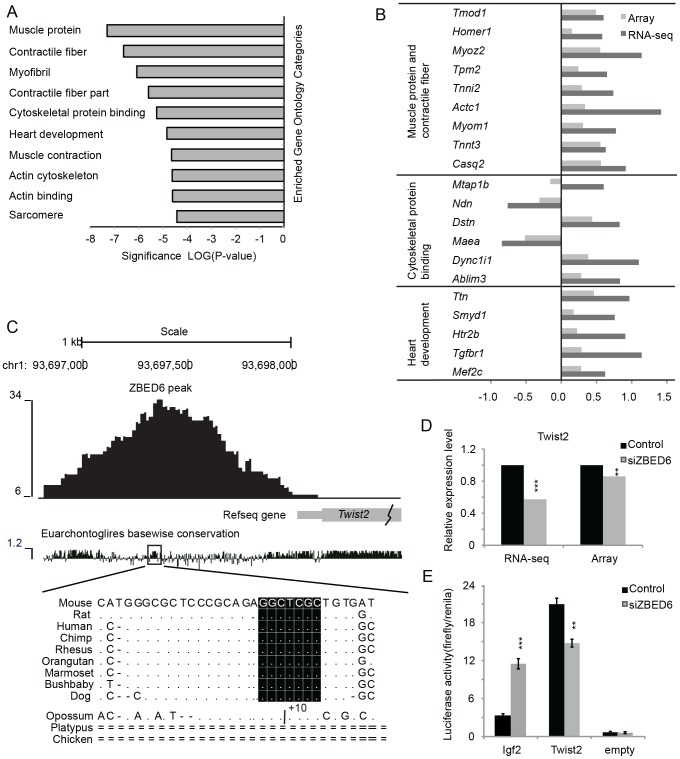
Muscle proteins were significantly enriched among the differentially expressed (DE) genes.(A) The significantly enriched GO categories (y-axis) in the DE genes with FDR <0.05. (B) The Log2 fold changes from both RNA-seq (dark) and arrays (grey) of the DE genes associated with muscle proteins and contractile fiber, cytoskeleton protein binding and heart development. (C) The ZBED6 peak at about 1 kb upstream of Twist2 gene (grey box) displayed together with placental mammal conservation score. The peak maxima overlapped with a highly conserved region (grey box), which contained the consensus motif GCTCGC of ZBED6 only in the placental mammals. A 10-bp insertion (+10) was present within the consensus motif in the opossum genome, indicating lack of ZBED6 binding site in this region. (D) The relative expression levels of Twist2 from RNA-seq and array in either Zbed6-silenced or control C2C12 cells. (E) The relative luciferase activity (the ratio of firefly to Renilla) of Igf2, Twist2 and empty pGL3 basic constructs in Zbed6-silenced or control C2C12 cells. **, P<0.01; ***, P<0.001.